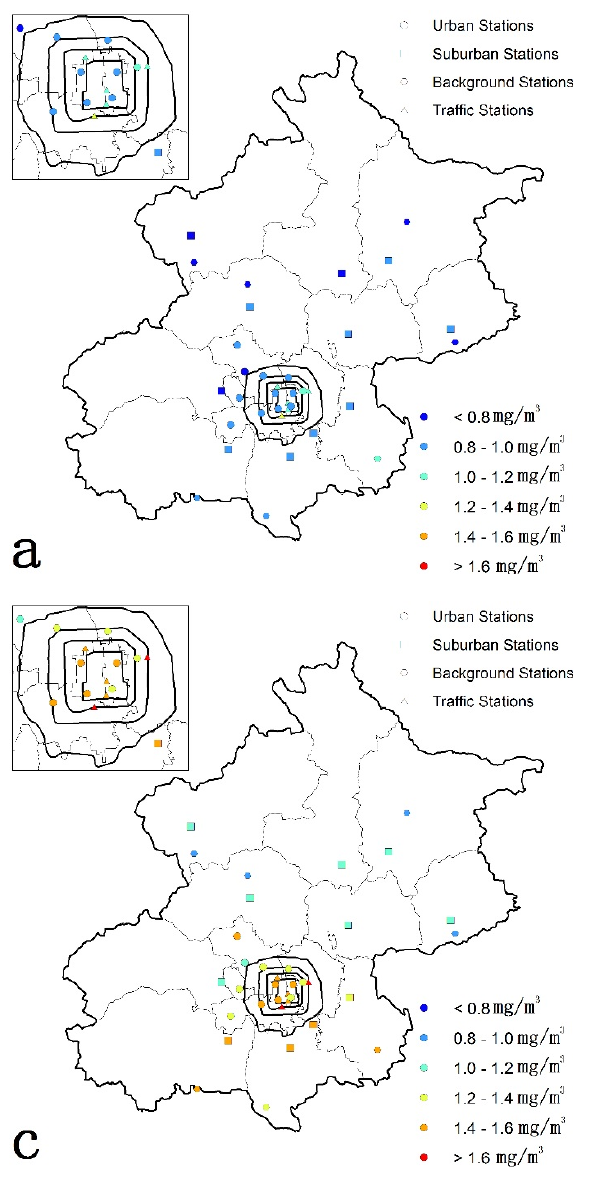
Figure 11. Seasonal variations of CO concentrations for the 35 air quality monitoring stations (( a ) spring; ( b ) summer; ( c ) autumn; ( d )